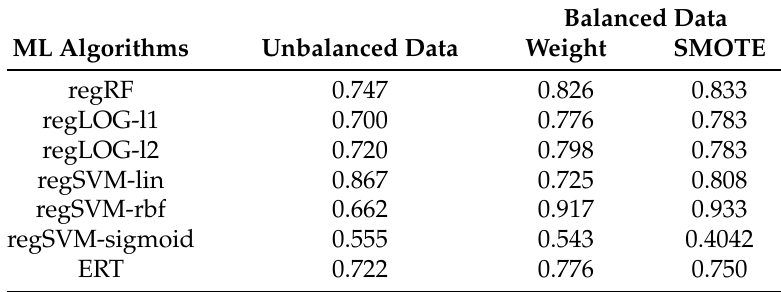
Table 1. The accuracy score of correct predictions are obtained for unbalanced and balanced data, for the various algorithms employed in this paper. The most accurate results are obtained for balanced data by use of the Support Vector Machine with rbf kernel